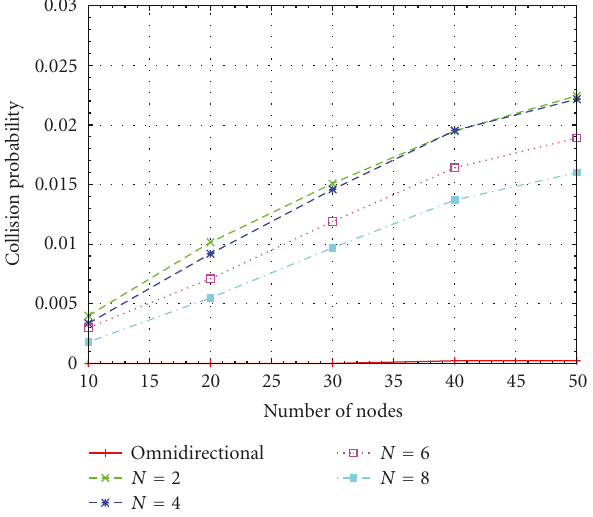
Figure 7: Collision probability as a function of the number of nodes in the case of omnidirectional and directive antennas with π , π/ 2, δ = 3%. π/ 3, and π/ 4 main lobes for T f = 93seconds and